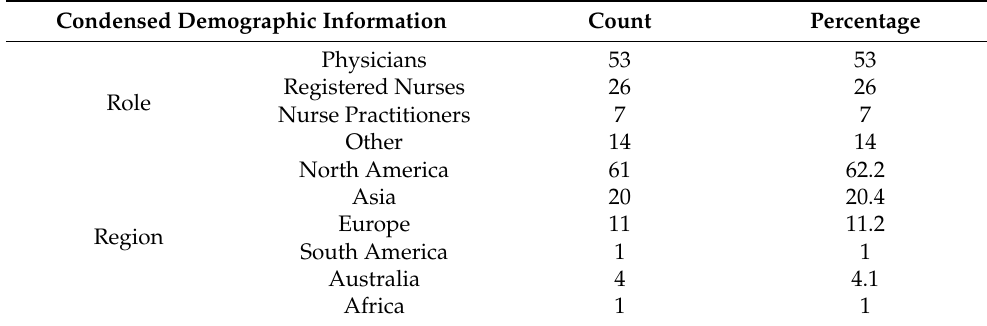
Table 2. Condensed demographics used for data analysis to determine if there was a correlation between stressors and wellbeing during the COVID-19